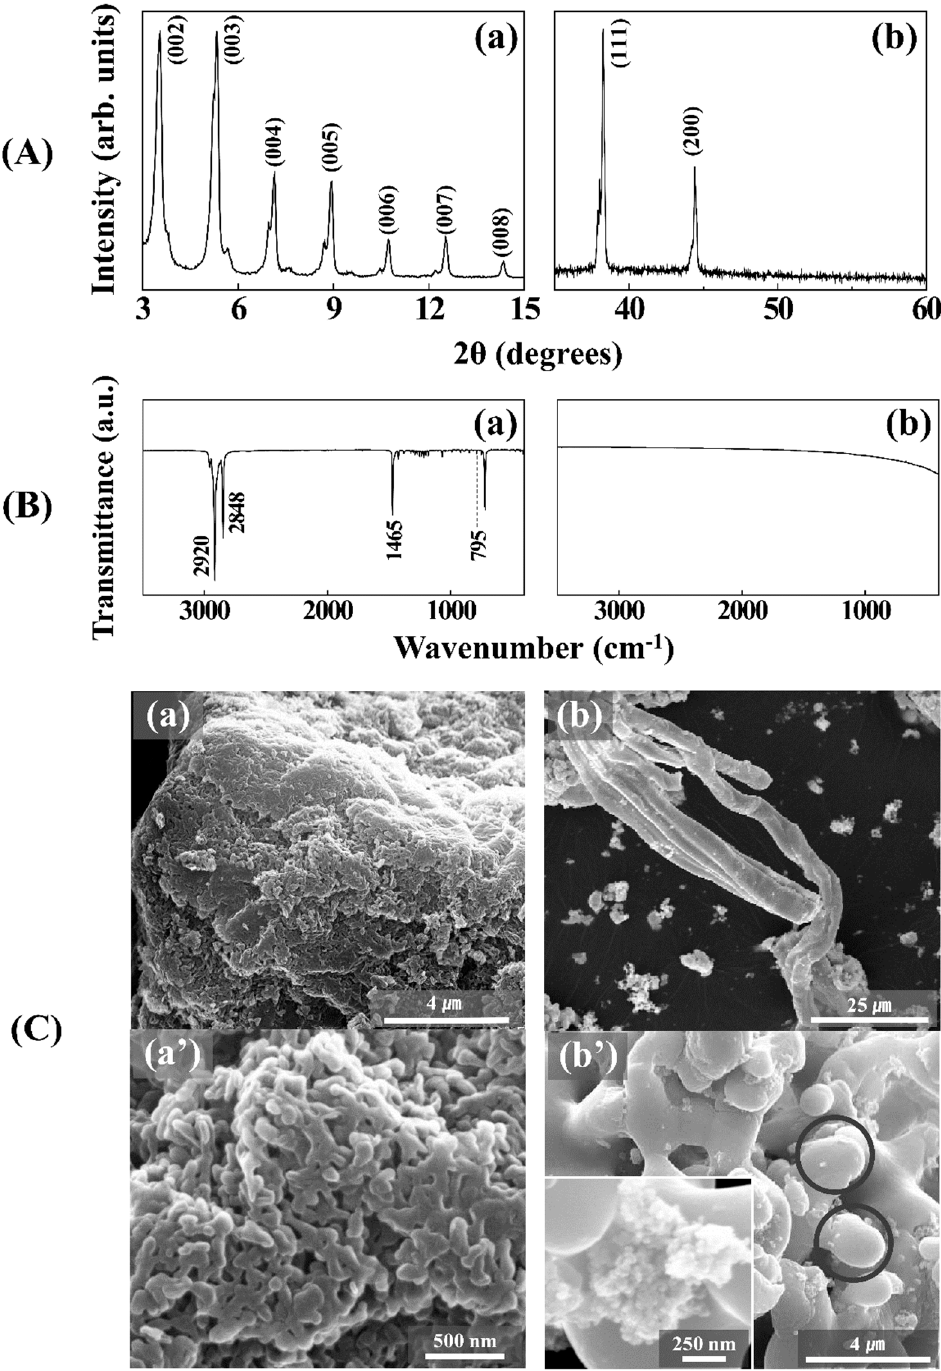
Figure 1. ( A ) X-ray diffraction patterns, ( B ) Fourier transform infrared spectra, and ( C ) scanning electron microscopic images of ( a ) AgSC18 and ( b ) calcined AgSC18 in powder state. ( C ( a’ , b’ )) are magnified images corresponding to ( a ) and ( b ). For the calcination, powder state AgSC18 was thermally treated at 500 ° C for 4 h under reductive gas condition (N 2 :H 2 = 9:1). The solid circle and inset in ( C ( b’ )) indicate micrometer- and nanometer-sized Ag particles, respectively.